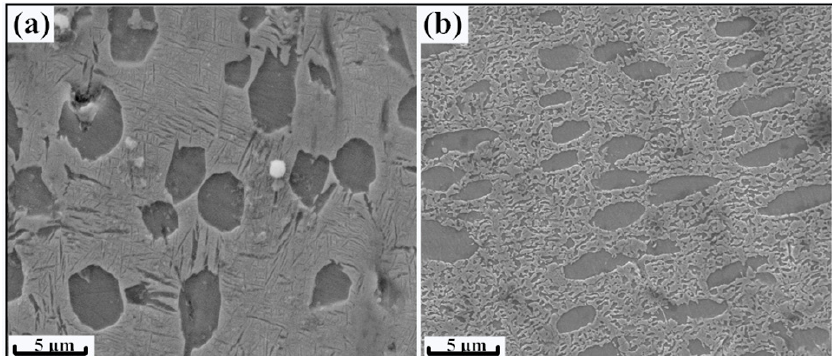
Figure 2. SEM morphologies of bi-modal Ti-55511 alloys ( a ) before and ( b ) after hot rolling.